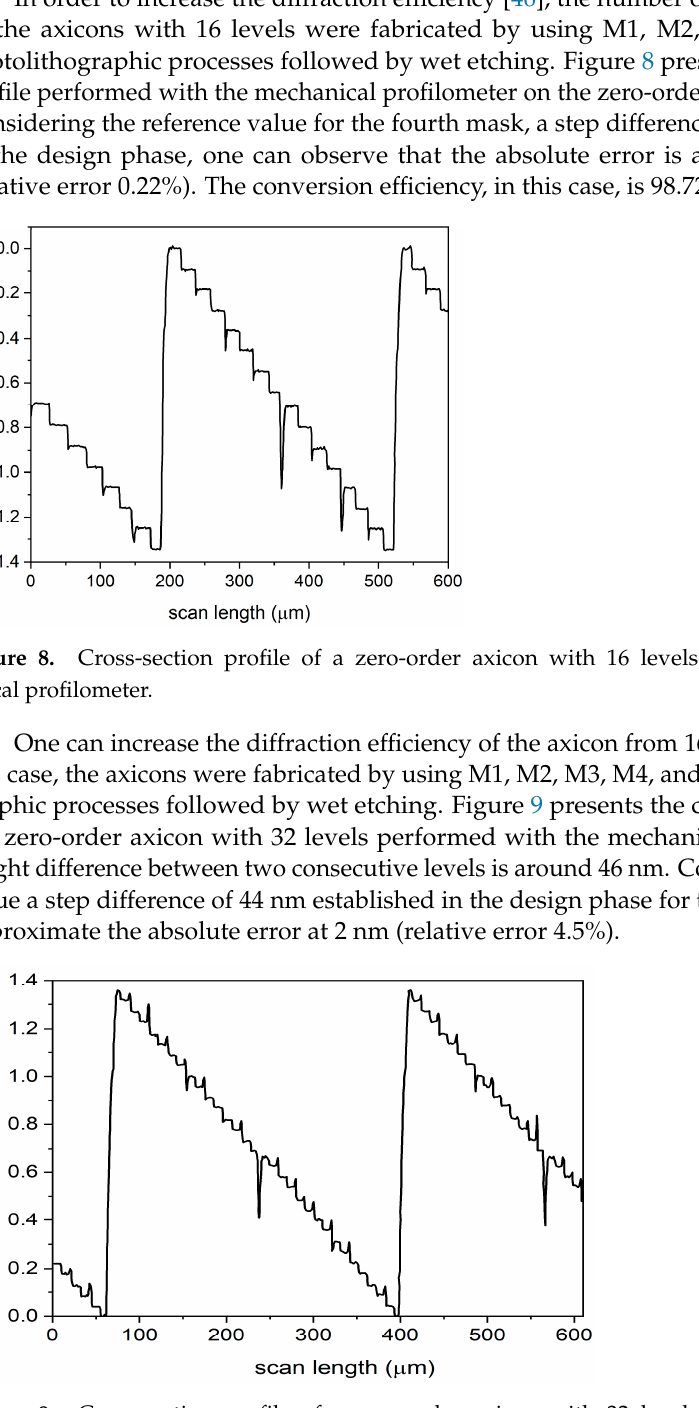
Figure 9. Cross-section profile of a zero-order axicon with 32 levels, measured with mechanical pro- filometer.